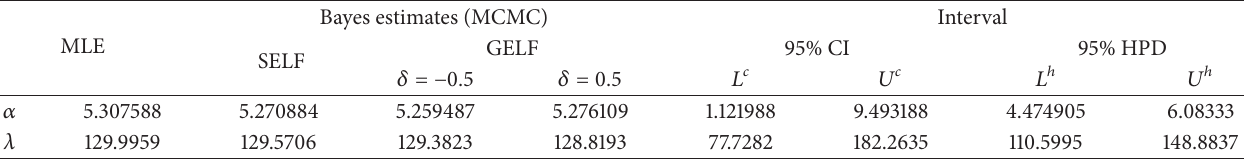
Table 7: Bayes and ML estimates based on real data set for 𝑛 = 23 , 𝑝 = 0.05 .